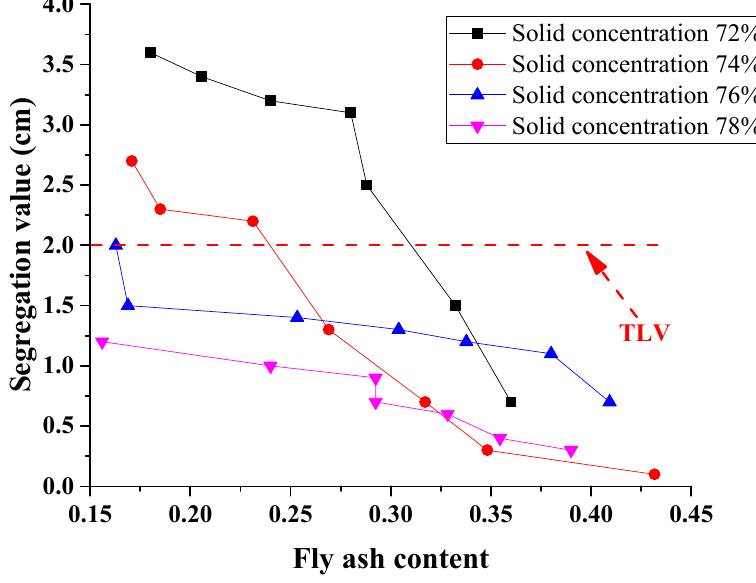
Figure 7. Effects of fly ash content on segregation property of CPB slurry.